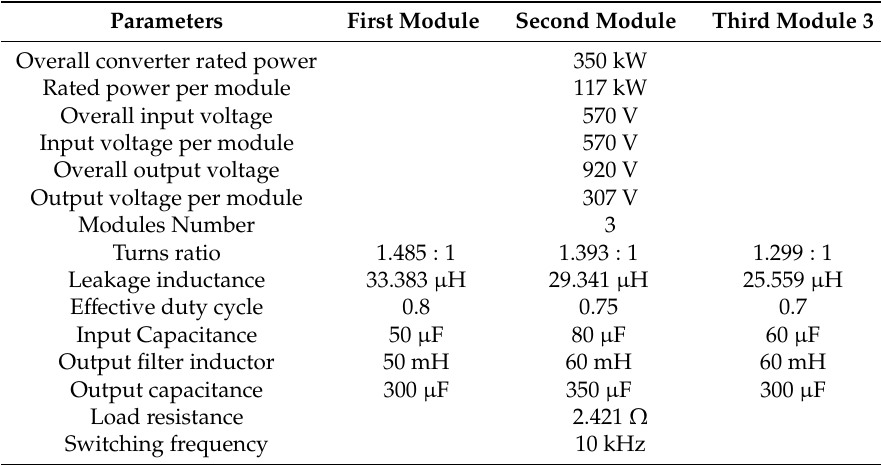
Table 10. IPOS converter parameters.